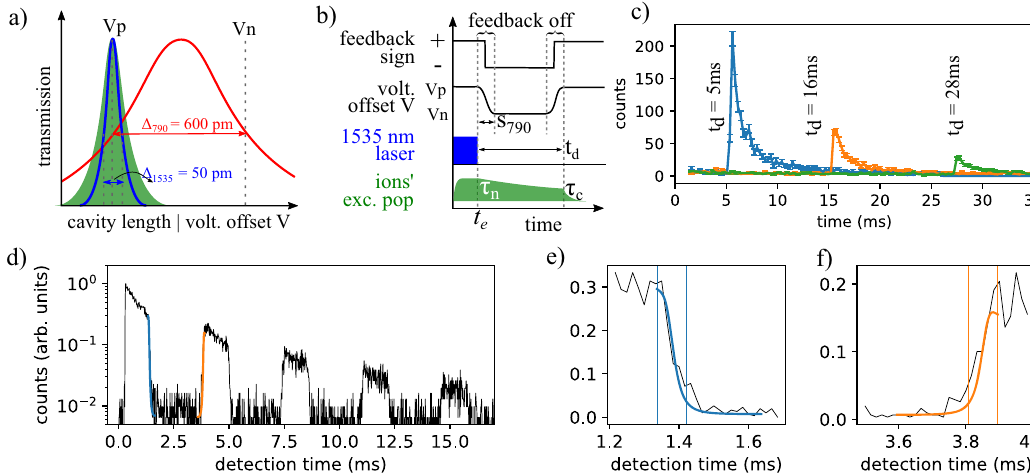
Fig. 3 Control of Purcell enhanced emission. a Scheme to stabilize the length of the cavity on/off-resonance with the ions. The cavity length is controlled by applying a voltage offset V that moves the fi ber. For V p , the transmission of the 790 nm locking laser is at the 50% level on the positive slope of the fringe (red curve), and on resonance with both the center of the inhomogeneous line of the ions (green area) and the 1535 nm excitation laser (blue fringe). For V n , the fi ber is displaced by d f = Δ 790 = 600pm with respect to the position of V p . The transmission of the 790 nm locking laser is at the 50% level but on the negative slope, and both the excitation 1535 nm laser and the center of the homogeneous line are detuned by 12 Δ 1535 (see main text for details). The cavity length can be stabilized to the 50% level of either 790-nm fringe, for which the feedback sign has to be adequately set. b Sequence used to extract τ n . First, V p is applied for a time t e and the 1535 nm resonance is driven. At a time t e , the voltage is switched from V p to V n in a time S 790 . The excited state population then decays at τ n . After a time t e + t d + S 790 , V n is switched back to V p . Feedback sign is set to positive (negative) for V p ( V n ), and feedback action is off in the transient stage of the voltage. c Counts recorded as function of time t for t d = 5, 16, and 28 ms. Error bars represent one standard deviation of photon counts. d Counts as function of time when the voltage is alternated between V p and V n fi ve times at intervals of 1 ms after excitation of the ions. Zooms of the falling ( e ) and rising ( f ) edges are also shown, revealing an average transition time of S 1535 = 85(15) μ s for the falling edge and 87 (16) μ s for the rising edge (see “ Discussion ” in the main